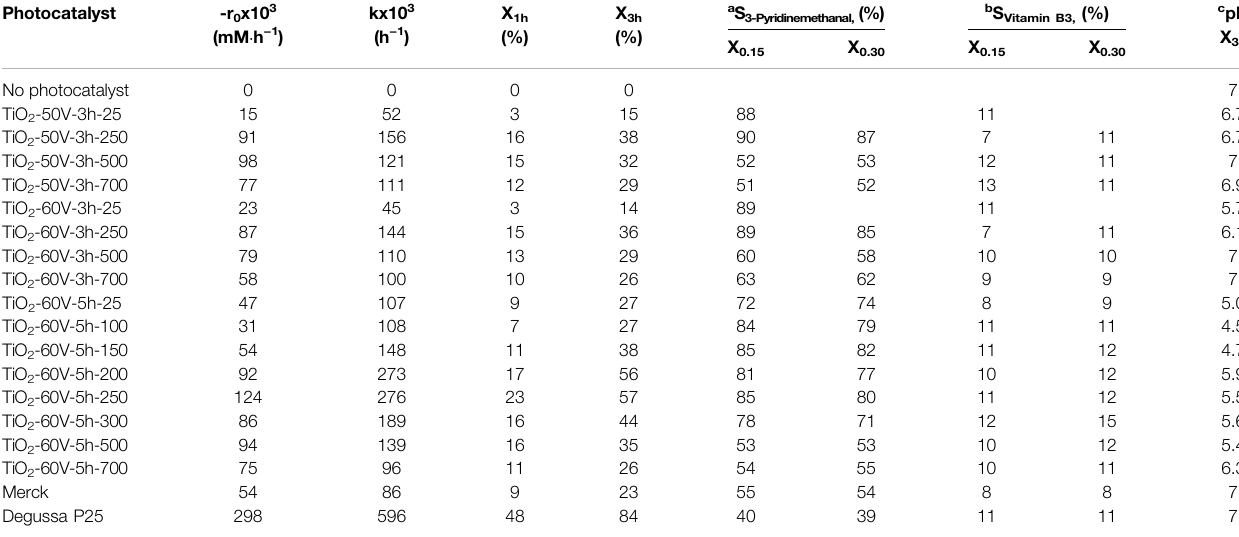
TABLE 5 | Photocatalytic results of 3-pyridinemethanol (0.5 mM) oxidation under UVA light with TiO 2 -50V-3h, TiO 2 -60V-3h, TiO 2 -60V-5h, and the commercial photocatalysts prepared at different calcination treatment temperatures.